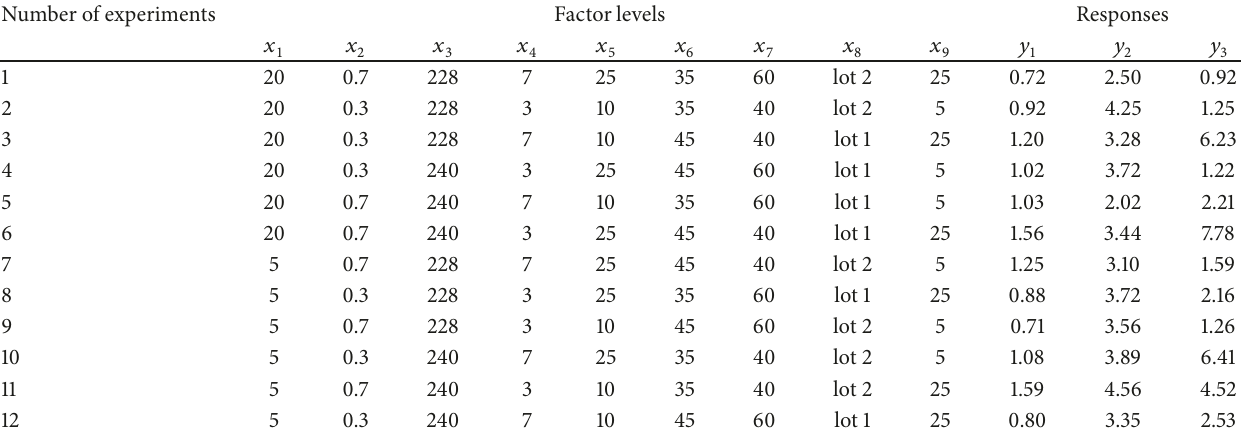
Table 1: Plan of Plackett–Burman design and experimentally obtained results. Number of experiments Factor levels